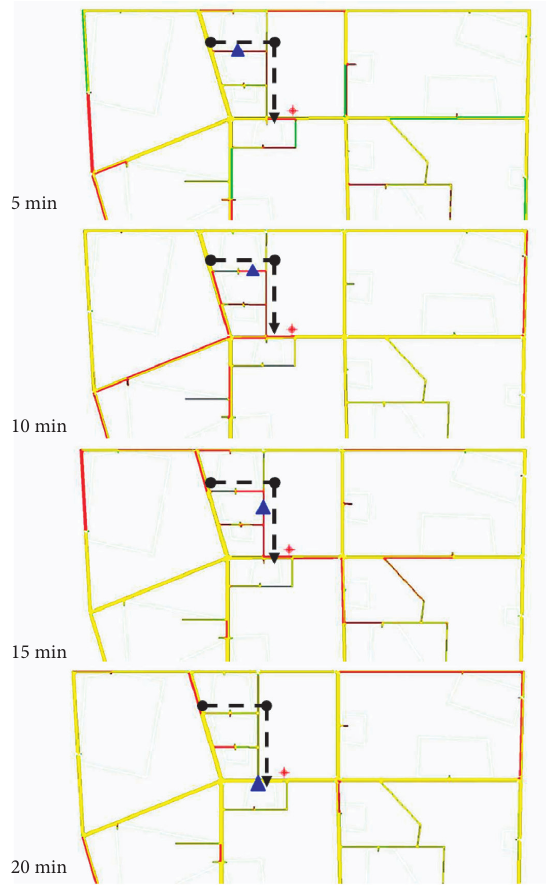
Figure 6: Visualization of the attention for each traffic state input. (The color of road segment represents the level of attention, red represents high attention, yellow represents medium attention, and green represents low attention. The black dash line represents the driving route of shared electric vehicle, and the blue triangle represents the current position of shared electric